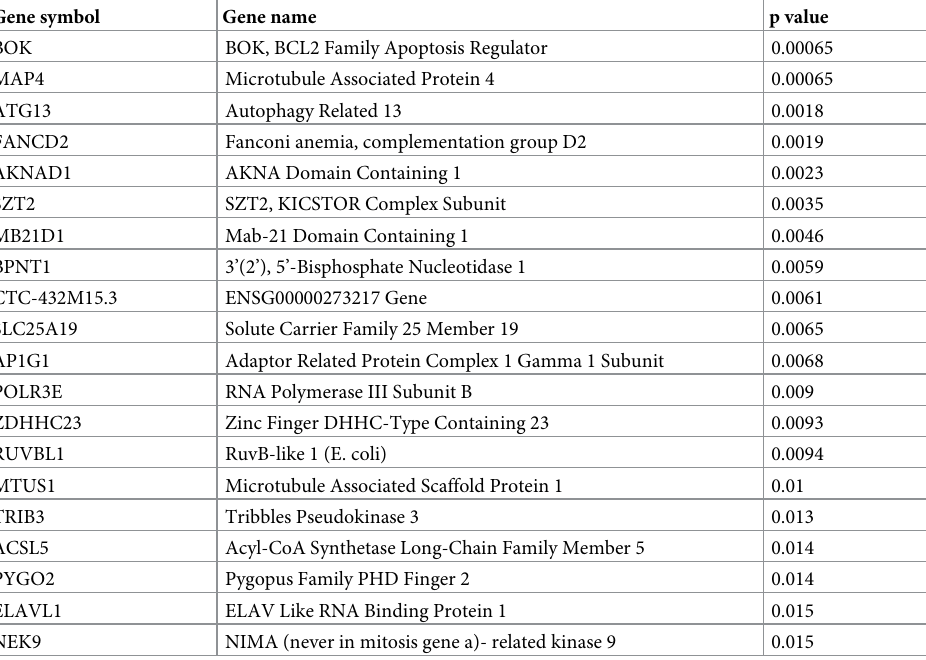
Table 3. The list of top 20 significant genes after junction analysis of the CPSF1 overexpression